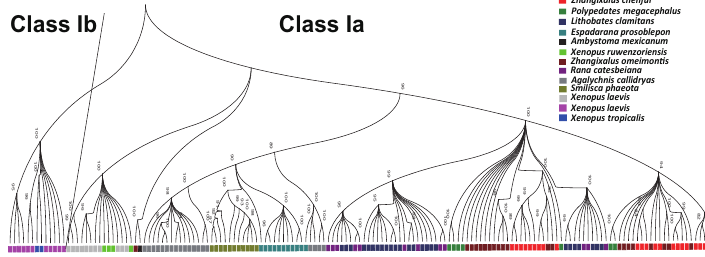
Figure 3. Phylogenetic relationships of anuran MHC class Ia and Ib genes. The neighbor-joining tree was constructed with MEGA5 using all available anuran MHC class I genes with an available length. Bootstrap values are indicated above the branches. Sample names are not shown due to the large size of the tree. Rather, the species to which these samples belong are denoted with di ff erent colors. The horizontal line separates MHC class Ia genes (to the right of the line) and MHC class Ib genes (to the left of the line).